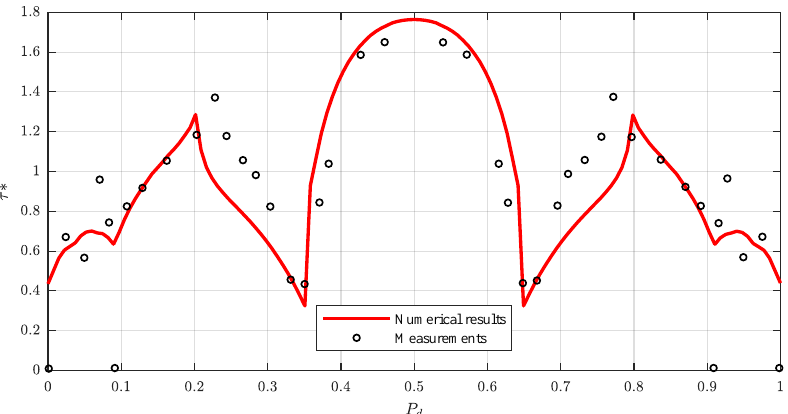
Figure 15. Comparison of calculated and measured boundary shear stress distributions in a rough compound channel of the experiments of Ghosh and Mehta [37].